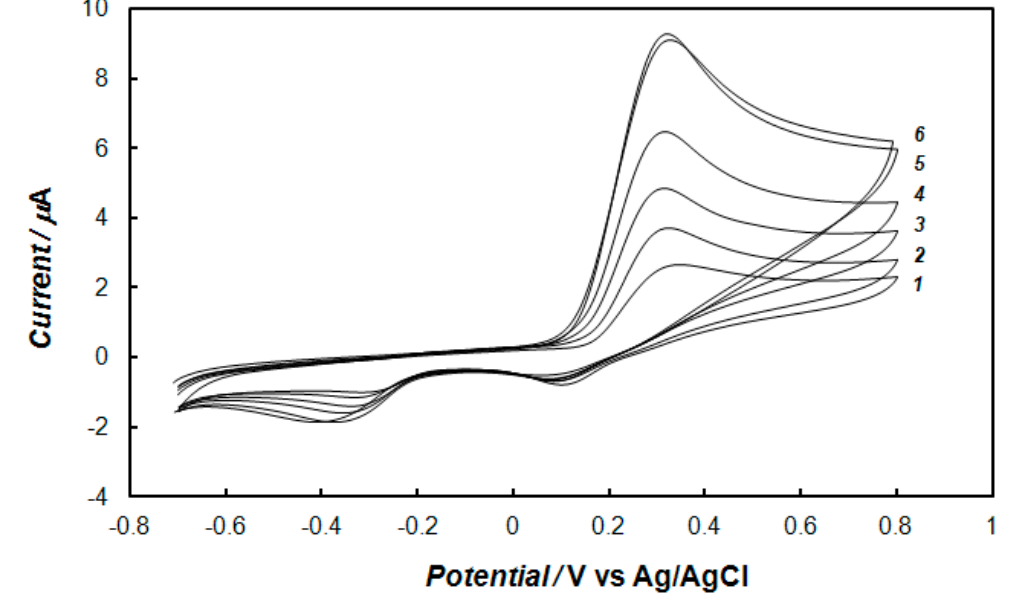
Figure 4. Cyclic voltammograms recorded at the gold electrode modified with the polypyrrole—MCM-48 nanocomposite after ( 1 ) 0, ( 2 ) 1, ( 3 ) 3, ( 4 ) 5, ( 5 ) 10, and ( 6 ) 15 min of preconcentration in 0.1 M of phosphate buffer solution (pH 7.4) containing 1 mM of dopamine, and at a potential sweep rate of 0.1 V s − 1 .